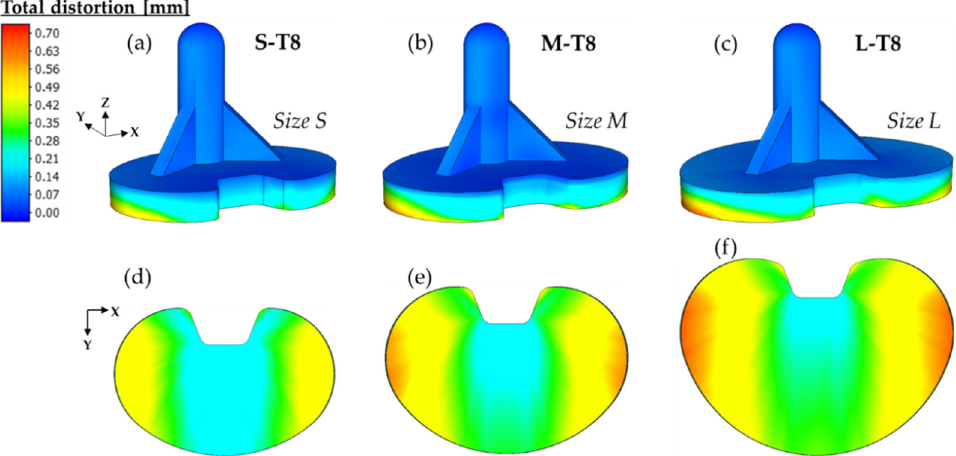
Figure 10. Total distortion of the as-built tibial component with different sizes. ( a , d ) Small size with 8 mm thickness (S-T8) ; ( b , e ) Medium size with 8 mm thickness (M-T8); ( c , f ) Large size with 8 mm thickness (M-T8).